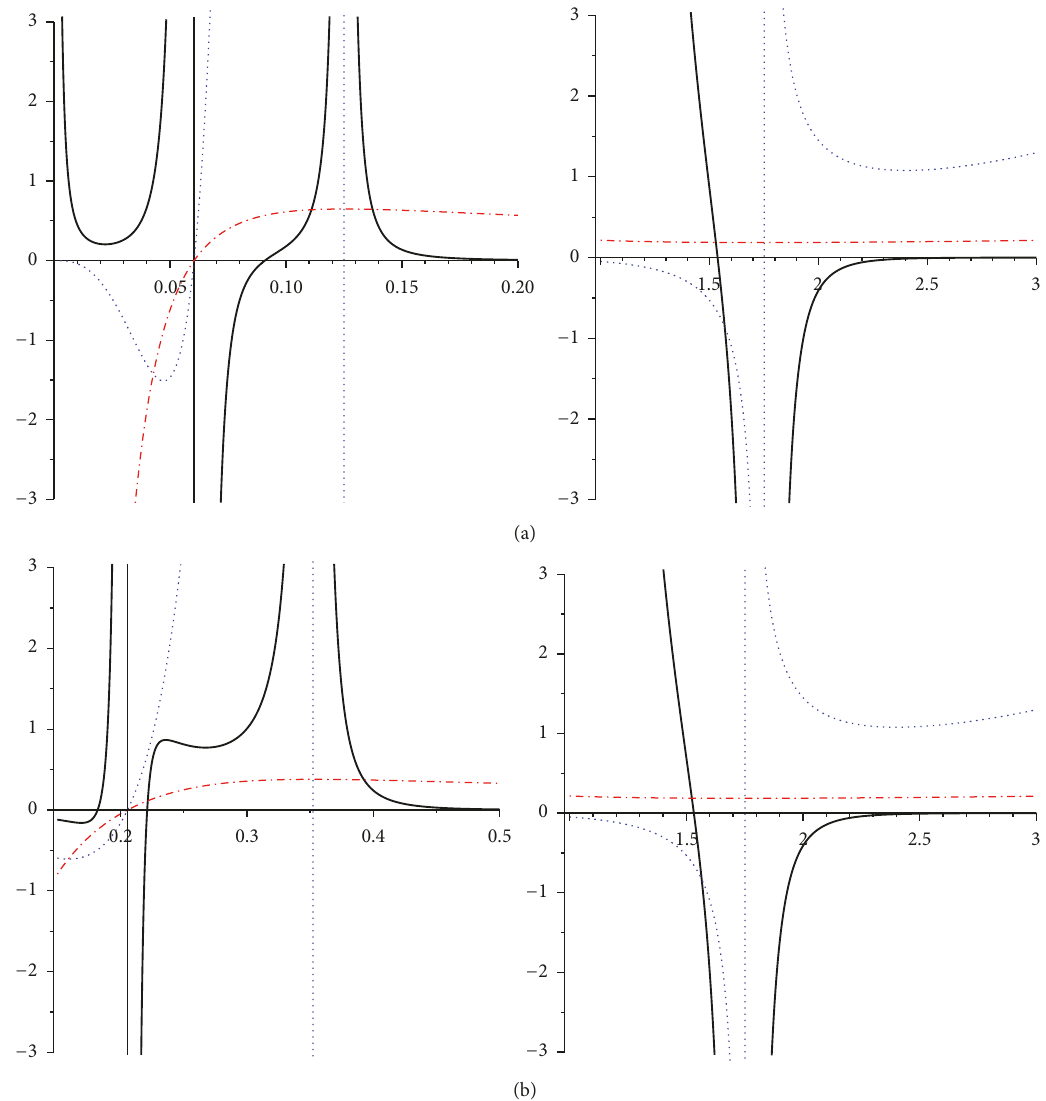
Figure 4: HPEM metric. R (continuous line), 𝐶 𝑄 (dotted line), and 𝑇 (dot dashed) versus 𝑟 + for Λ = −1 , 𝑛 = 4 , 𝑞 = 0.1 , 𝑏 = 1 , and 𝜔 = 10 . 𝛽 = 1 (a) and 𝛽 = 5 (b). “Note: both panels in the same line are plotted with the same parameters, but different regions and scales.”